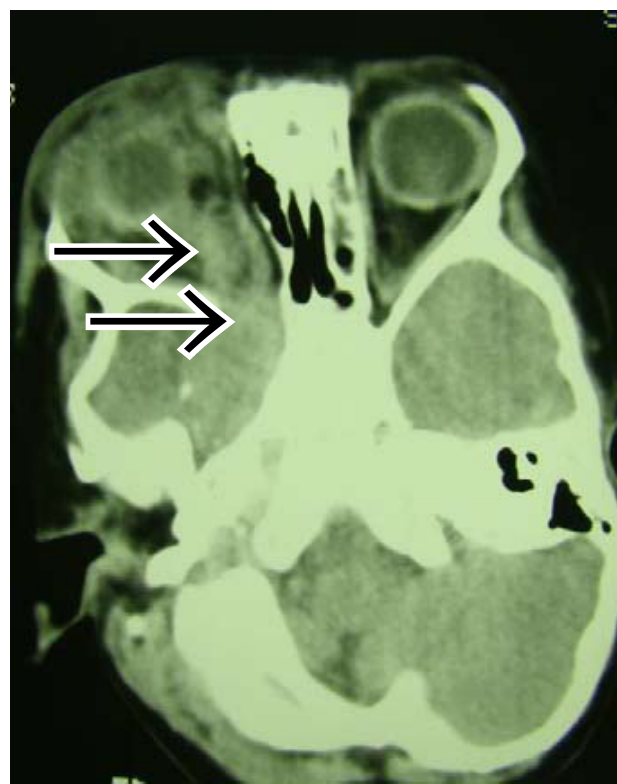
Fig. 5b. Axial non-enhanced brain CT showing plexiform neurofibroma of the right trigeminal nerve, optic glioma and partial hypoplasia of the greater wing of the sphenoid bone.